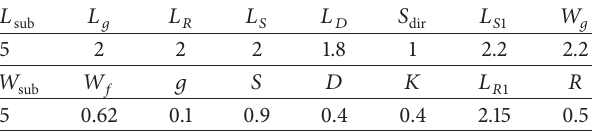
Table 1: Optimized proposed antenna dimensions